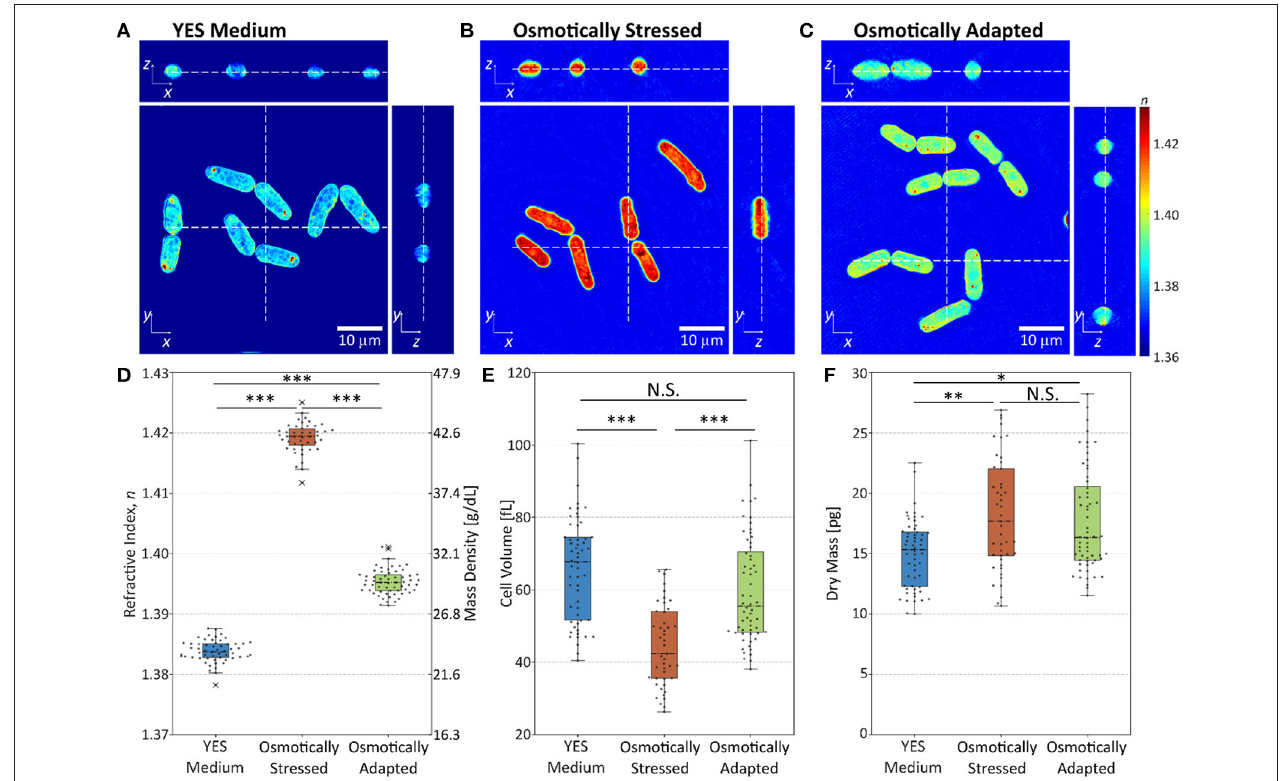
FIGURE 3 | The effect of osmotic stress and adaptation on yeast cells. (A–C) Cross-sectional slices in the x - y , y - z , and x - z planes of 3D RI tomograms of (A) control in YES medium, (B) osmotically stressed, and (C) osmotically adapted yeast cells. The scale bars correspond to 10 µ m, and dashed lines indicate corresponding cross-sectional slices. (D–F) The distribution of (D) RI, (E) cell volume, and (F) dry mass of control, osmotically stressed, and osmotically adapted yeast cells, respectively. The box plot indicates the interquartile ranges (IQR) with a line at the median. The whiskers extend to the data within the 1.5 IQR of the respective quartile. Outliers outside of 1.5 IQR are marked as (for each condition, N > 45). * p < 0.01; ** p < 0.001; *** p < ×